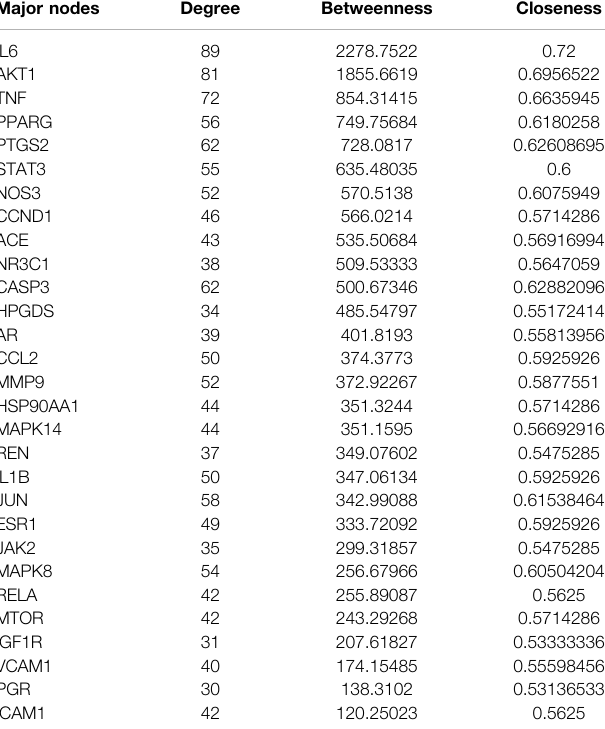
TABLE 4 | Topological features of major nodes. Major nodes